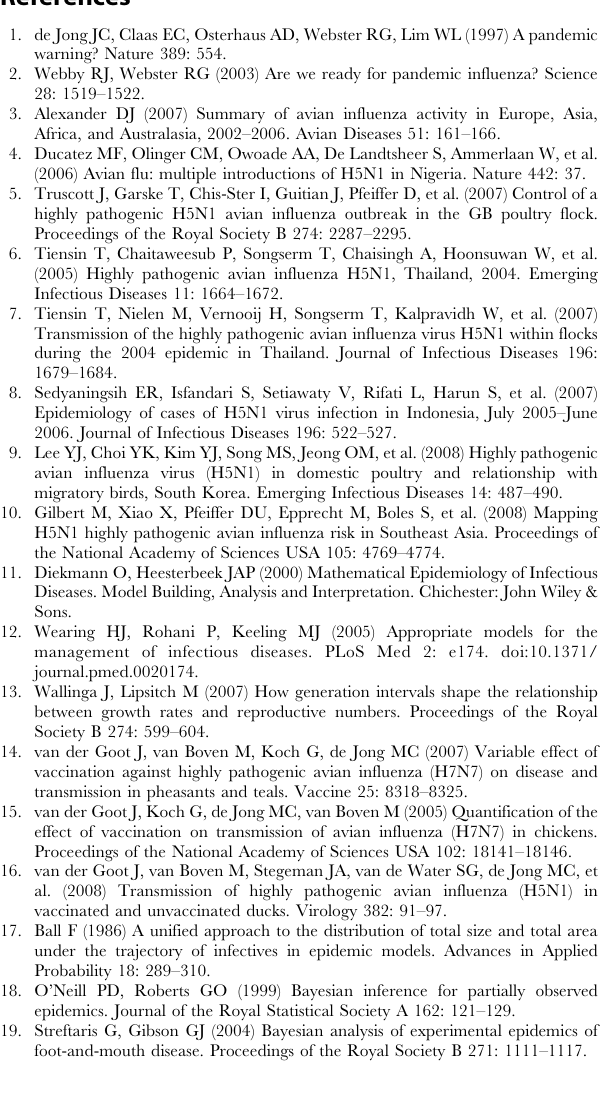
Table S7 Overview of experiment # 6 (see Table S1) with vaccinated birds inoculated with a high virus dose. The vaccine contained a heterologous H5N2 vaccine strain (A/Chicken/